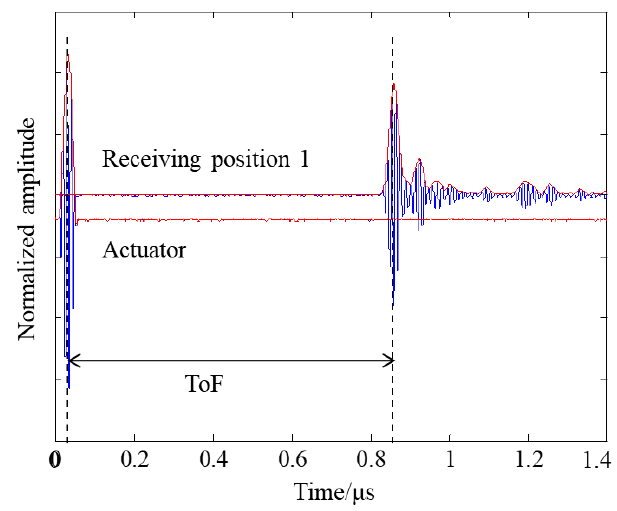
Figure 8. The scattered signals received by the sensor at receiving position 1. The blue line represents the signals and the red line represents the envelope obtained by Hilbert transform.